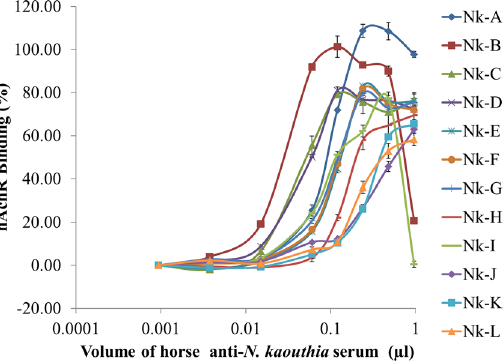
Figure 3. Effects of horse anti- N. kaouthia sera in neutralizing N. kaouthia venom as determined by nAChR binding to NK3-coated plate. nAChR binding were expressed as mean ± S.D. of 4 determinations.